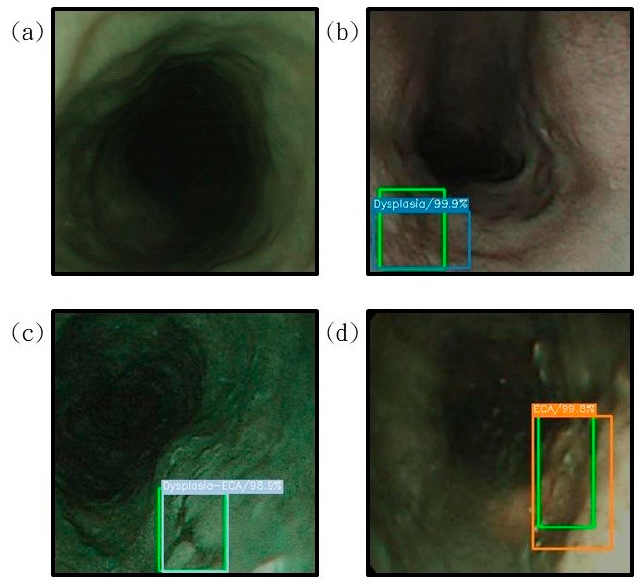
Figure 5. The results of the prediction of esophageal cancer are displayed on the narrow-band endoscopic imaging, where the correct position ( green rectangle ) is compared with the predicted result; ( a ) is the normal esophageal test result, which is not displayed under the diagnosis of SSD; ( b ) shows the detection result with low-grade dysplasia. Under the diagnosis of SSD, the blue bounding box surrounds the lesion area; ( c ) shows with the area between high-grade dysplasia and low-grade dysplasia. The test result shows that the gray bounding box surrounds the lesion area under the diagnosis of SSD; ( d ) shows the detection result of the invasive cancer area, and the orange bounding box surrounds the lesion area under the diagnosis of SSD .